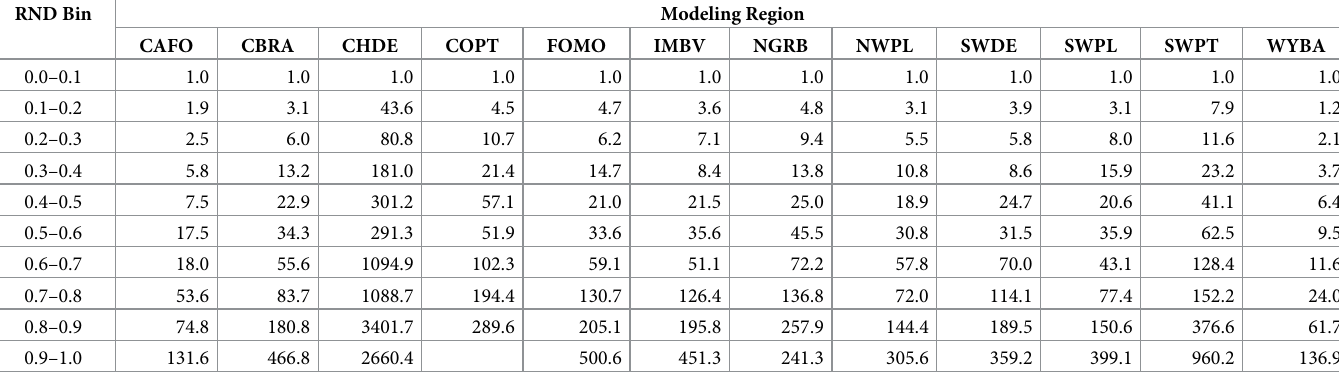
Table 6. Factor by which golden eagle nest density varies from the lowest bin for each modeling regions’ final model. RND Bin